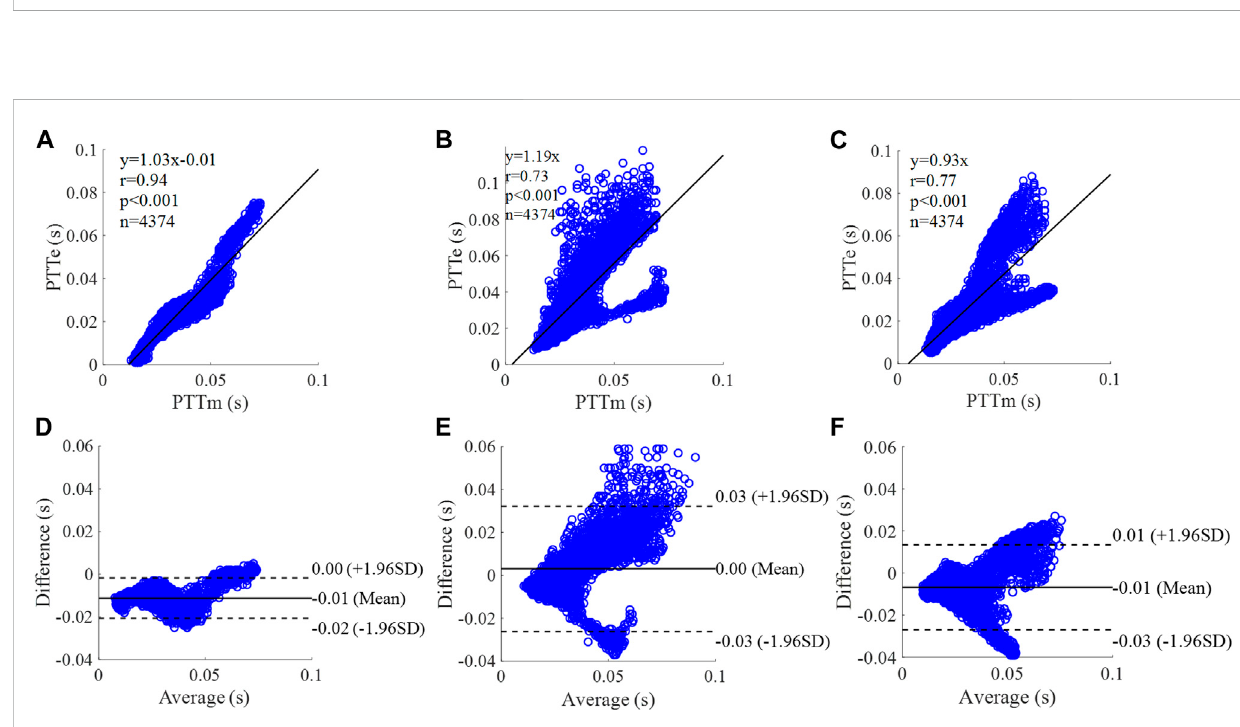
FIGURE 13 CorrelationgraphsandBland-AltmanplotsofRIcalculatedbythree fl owwaveforms. (A) and (D) Resultsofthepersonalized fl owwave(Clinicaldata, 13 participants); (B) and (E) Results of the triangular fl ow wave (Clinical data, 13 participants); (C) and (F) Results of the lognormal fl ow wave (Clinical data, 13 participants). RIm and RIe are measured and estimated RI, respectively. Difference: RIe - RIm; Average: (RIe + RIm)/2.